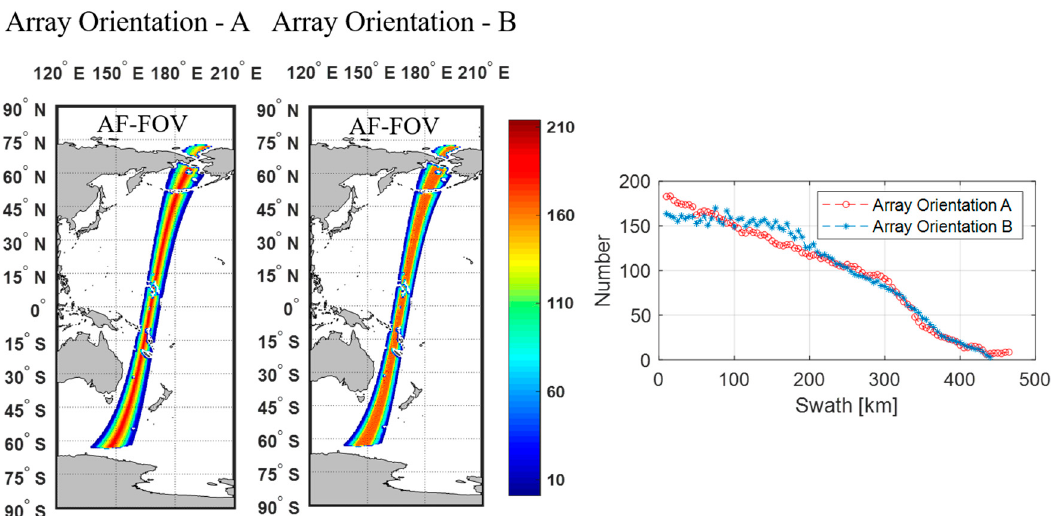
Figure 9. Illustration of the numbers of the repeated measurements in 25 km EASE grid when using the AF-FOV for simulation. The color maps in the left present the distributions of the numbers measured along orbit for two different array orientation. The plots in the right show the variations of the numbers versus the distance to the swath center for two different array orientations.